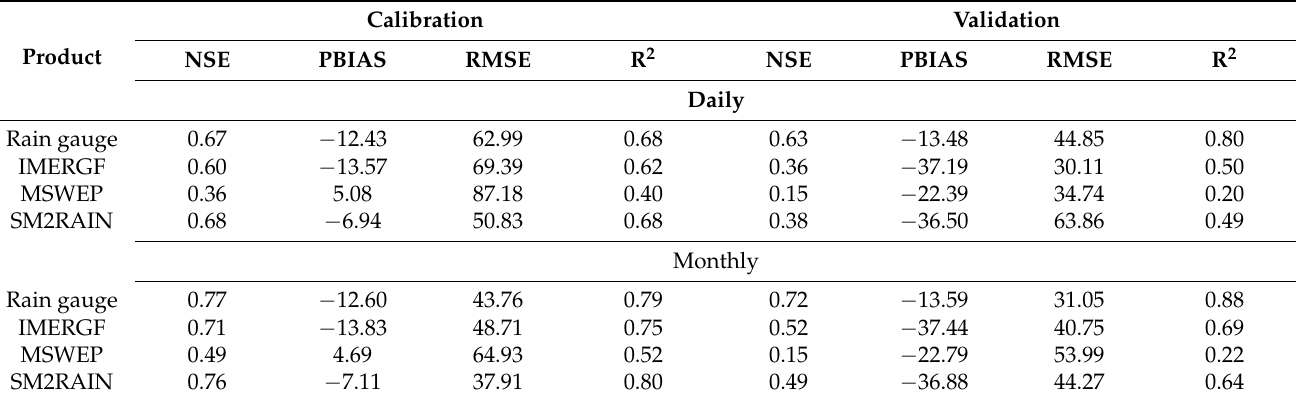
Table 5. Summary of SPPs’ performances using statistical